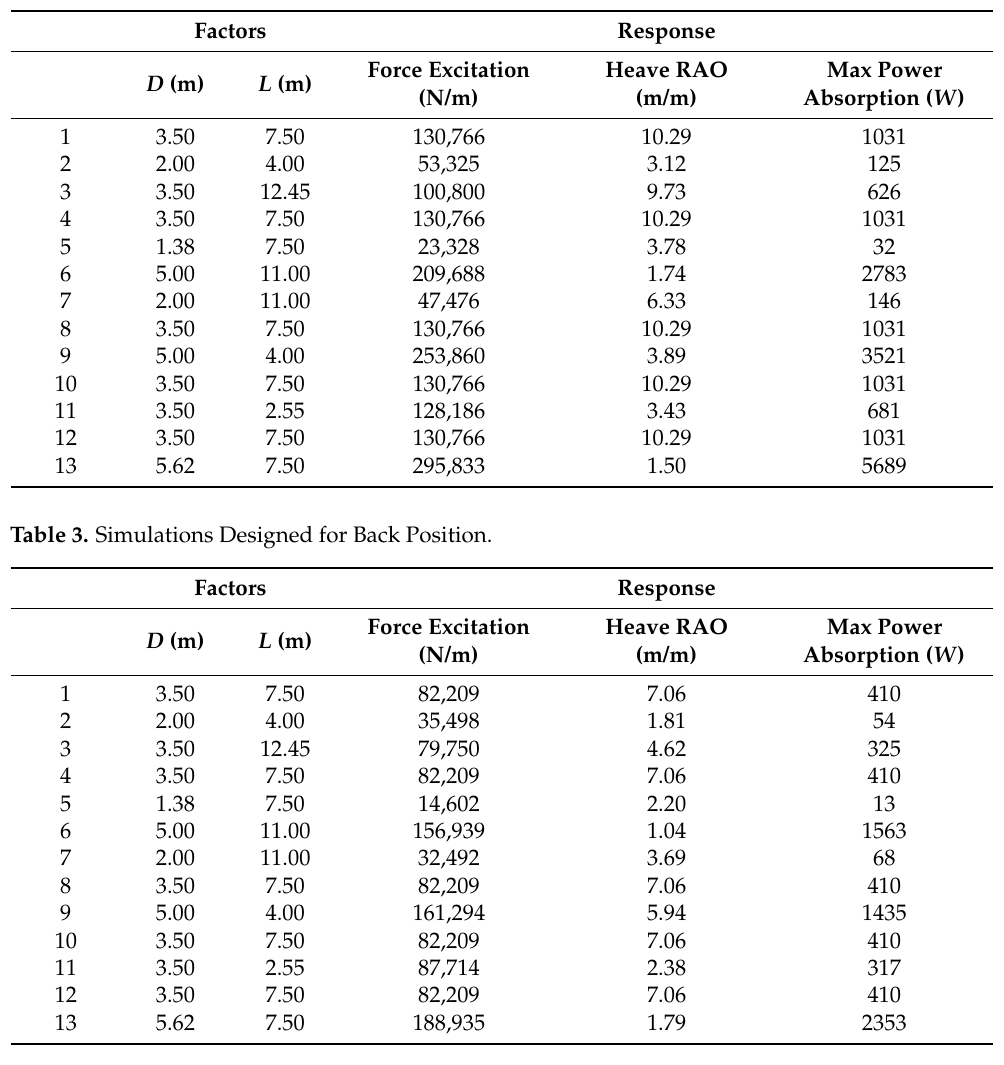
Table 2. Simulations Designed for Front Position.